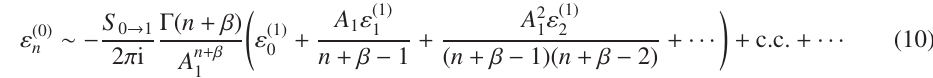
(cid:31) , in the complex ξ hydro (cid:31) (cid:30)